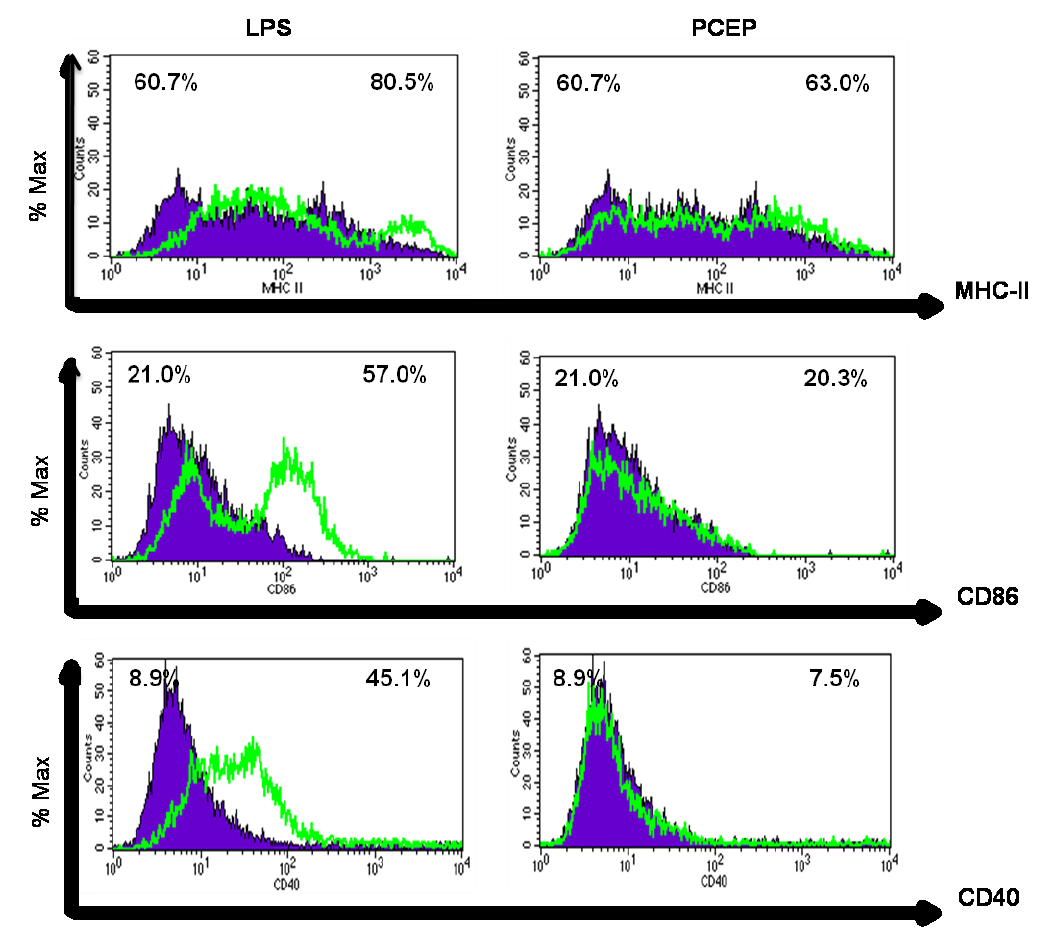
Figure 3. PCEP does not induce MHC class II and co-stimulatory molecules expression in vitro . Bone marrow-derived dendritic cells (BMDCs) (1 × 10 6 cells/mL) were incubated with media, PCEP (50 μg/mL) or lipopolysaccharide (LPS) (100 ng/mL) for 24 h. Cells were stained with MHC class II, CD 86 and CD40 antibodies and analyzed by flow cytometry. The overlay histograms show the % of maximum cells positive for MHC class II, CD86 or CD40 in PCEP- and LPS-treated BMDCs. The blue shaded area represents media control, and the green overlay line represents LPS- and PCEP-treated